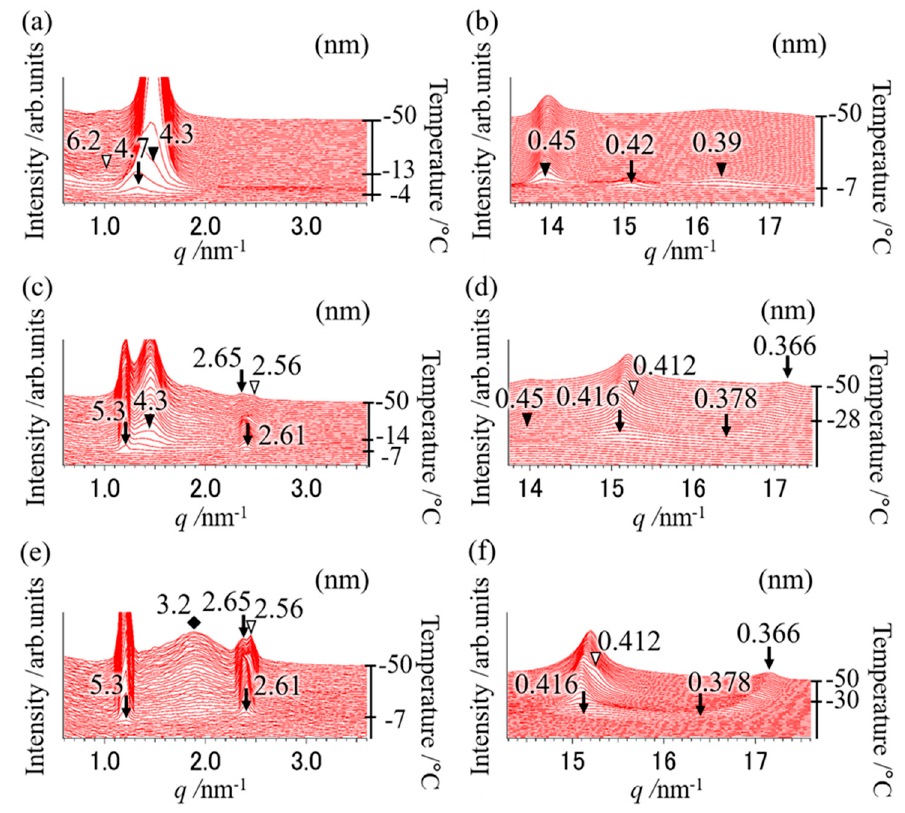
Figure 5. SR-TXRD results at the cooling rate of ( a , b ) 10 ◦ C min − 1 , ( c , d ) 15 ◦ C min − 1 , and ( e , f ) 25 ◦ C min − 1 with a binary mixture of OPO / POP = 6 / 4. The x-axes show q value ( q = 4 π · sin ( θ ) / λ ). The left y-axes show diffraction intensity. The right y-axes show temperature. ( a , c , e ) indicate magnification of small-angle pattern. ( b , d , f ) indicate magnification of wide-angle pattern. The arrows are derived from POP crystals (4.7 and 0.42 nm: α form, 5.3, 0.416, etc., nm: sub- α form). The closed triangles are derived from β -2 MC. The open triangles and diamond are derived from α -2 OPO.